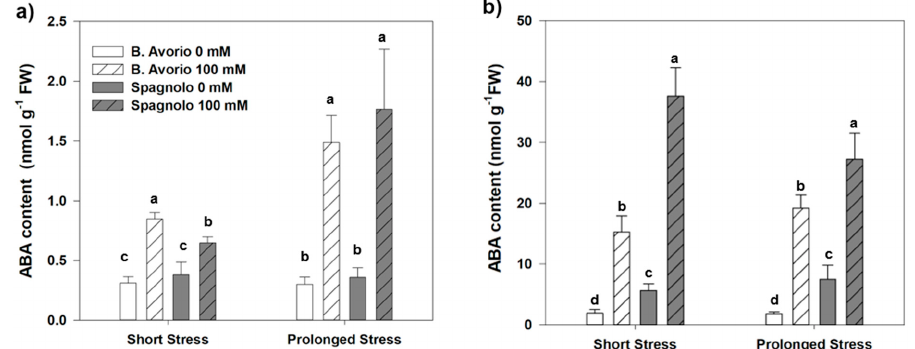
Figure 1. Levels of abscisic acid (ABA) in ( a ) roots and ( b ) leaves of “Bianco Avorio” and “Spagnolo” C. cardunculus var altilis genotypes after 2 and 21 days of 0 (control) and 100 mM (salinity treatment) NaCl. Each value represents the mean ± SD of three biological replicates. Values indicated with different letters are significantly different between genotypes and treatments within the same sampling time at p < 0.05, by analysis of variance (ANOVA).